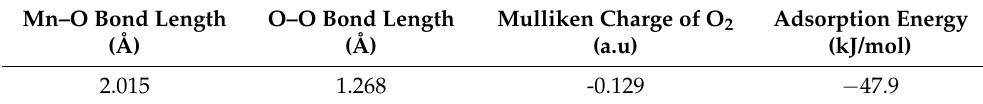
Figure 7. The partial density of state of O 2 adsorption configuration.